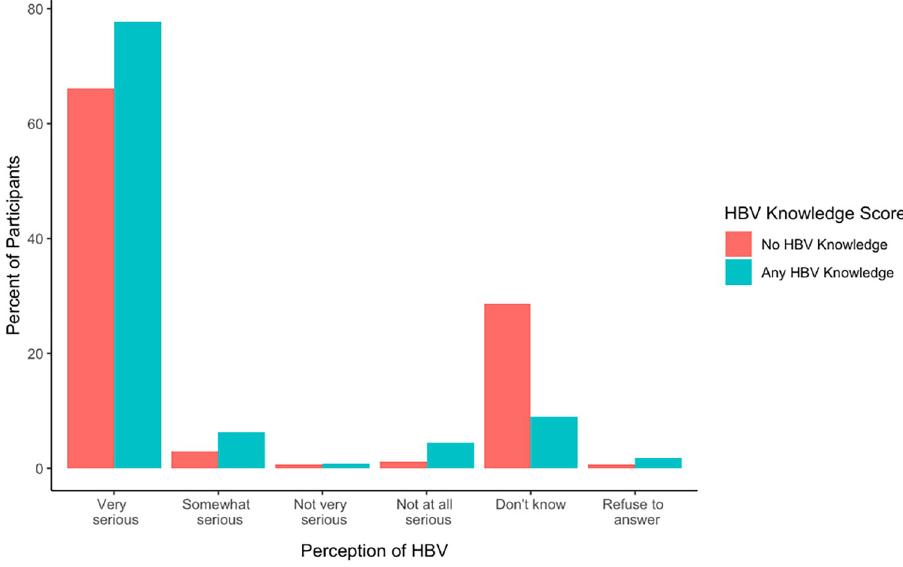
Fig 3. Participants responses to the question “in your opinion, how serious a disease is hepatitis B?” among women with no HBV knowledge (score of 0 on HBV knowledge assessment) and women with any HBV knowledge (score > 0 on HBV knowledge